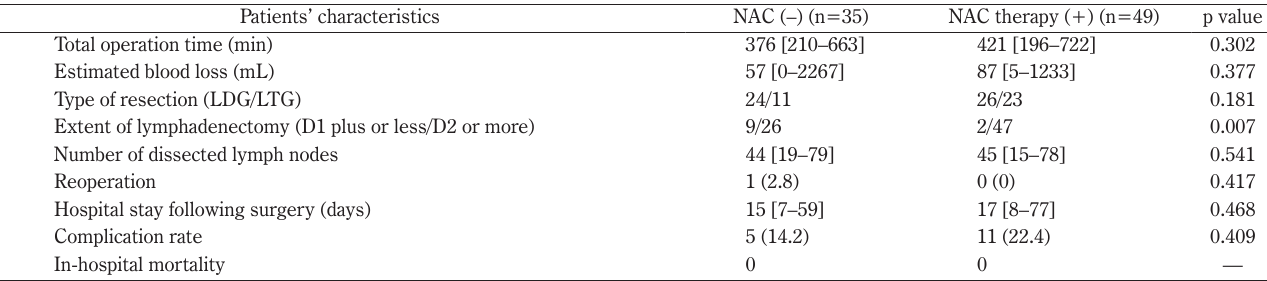
Table 3 Surgical outcomes and short-term postoperative course in patients who underwent laparoscopic gastrectomy (n=84) Patients’